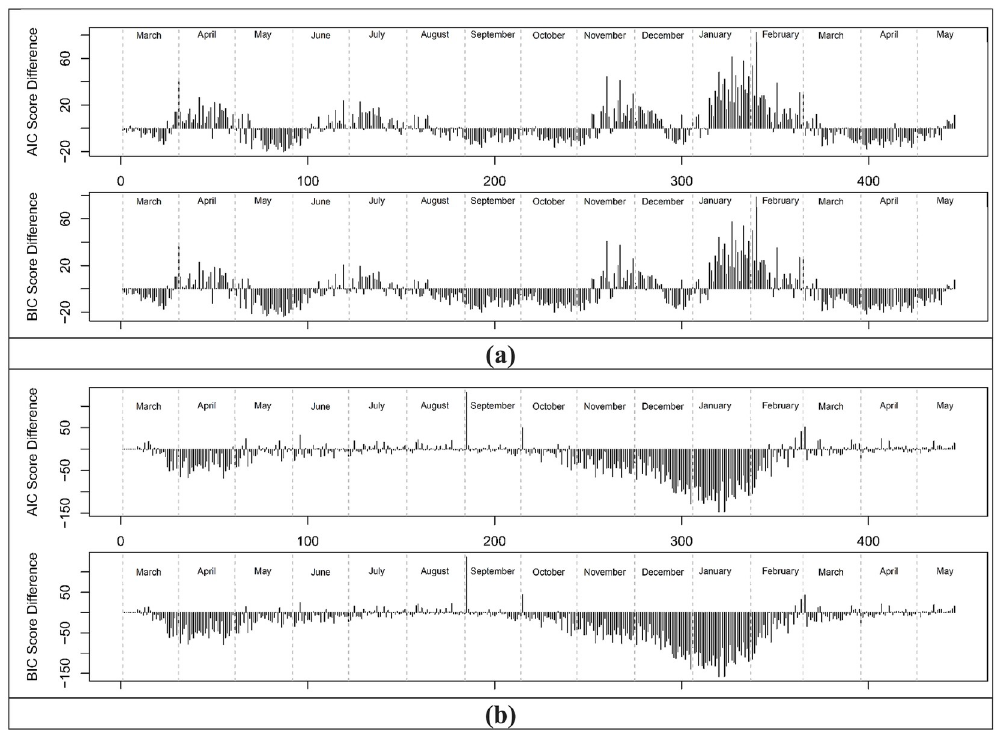
Fig 8. AIC and BIC differences over time. (a) COVID-19 cases and (b) COVID-19 death. Positive AIC/BIC indicates GL is a better fit and a negative AIC/BIC indicates normal is a better